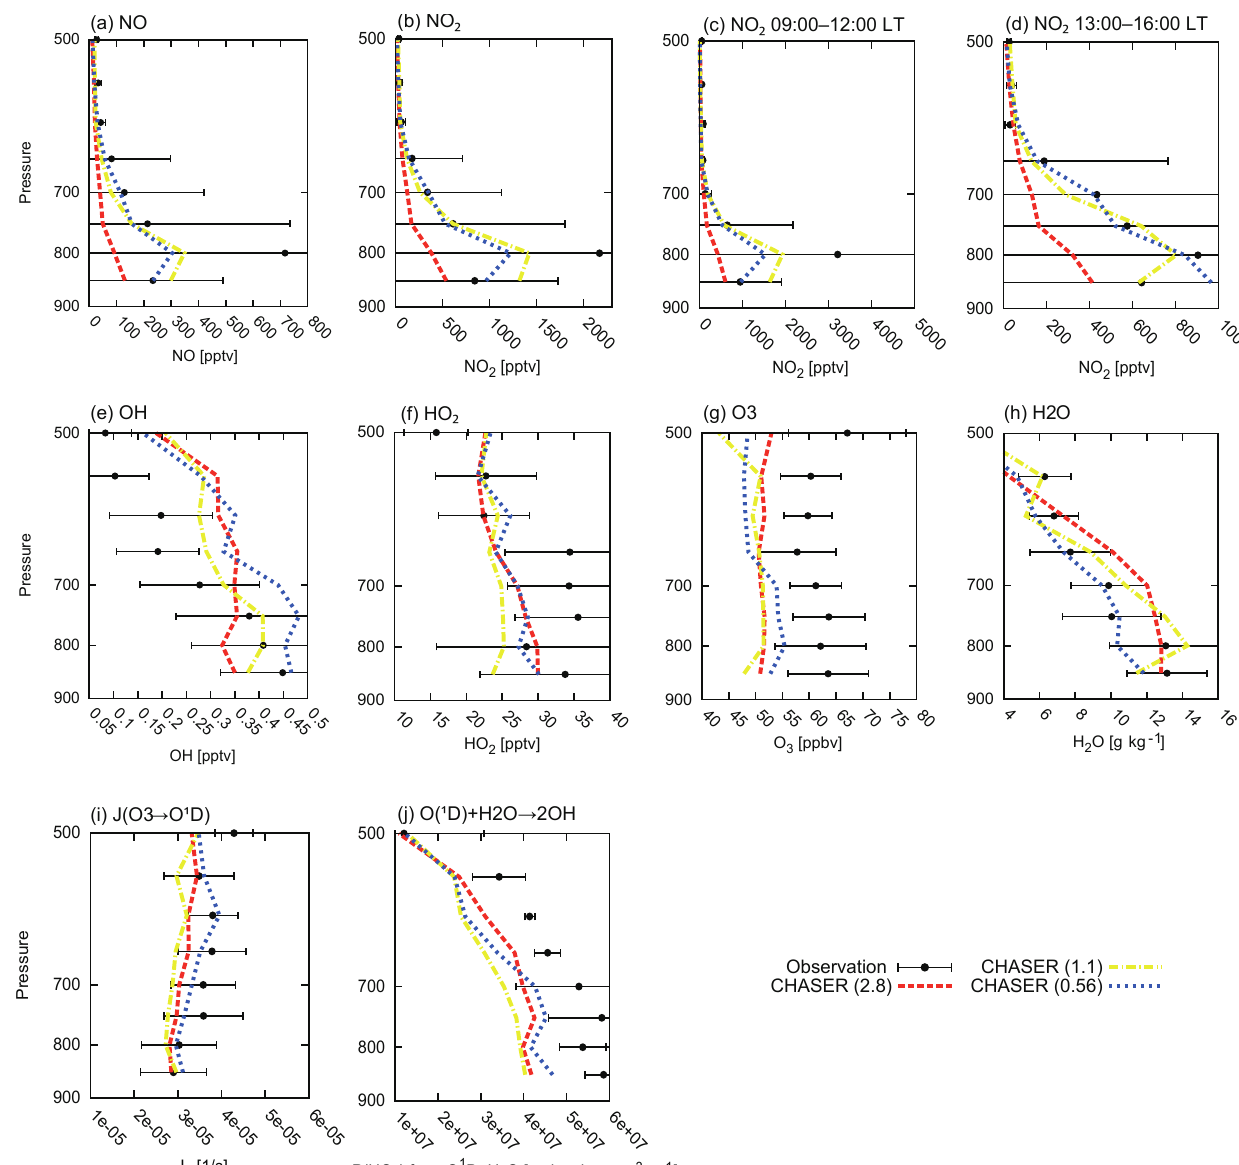
Figure 10. Vertical profiles of NO (pptv) (a) , NO 2 (pptv) (b) , NO 2 during mornings (09:00–12:00LT) (c) and afternoons (13:00– 16:00LT) (d) , OH (pptv) (e) , HO 2 (pptv) (f) , O 3 (ppbv) (g) , specific humidity (gkg − 1 ) (h) , the photolysis rate of O 3 (s − 1 ) (i) , and the OH chemical production rate (moleculescm − 3 s − 1 ) from O 1 D and H 2 O (j) over the Denver metropolitan area (39–41 ◦ N and 103–105.5 ◦ W) during the FRAPPÉ period (from 16 July to 18 August 2014). The black dots represent the measurements, the red dashed line is the model simulation at 2.8 ◦ resolution, the yellow dashed-dotted line is the model simulation at 1.1 ◦ resolution, and the blue dotted line is the model simulation at 0.56 ◦ resolution. The horizontal bars represent the standard deviation of the